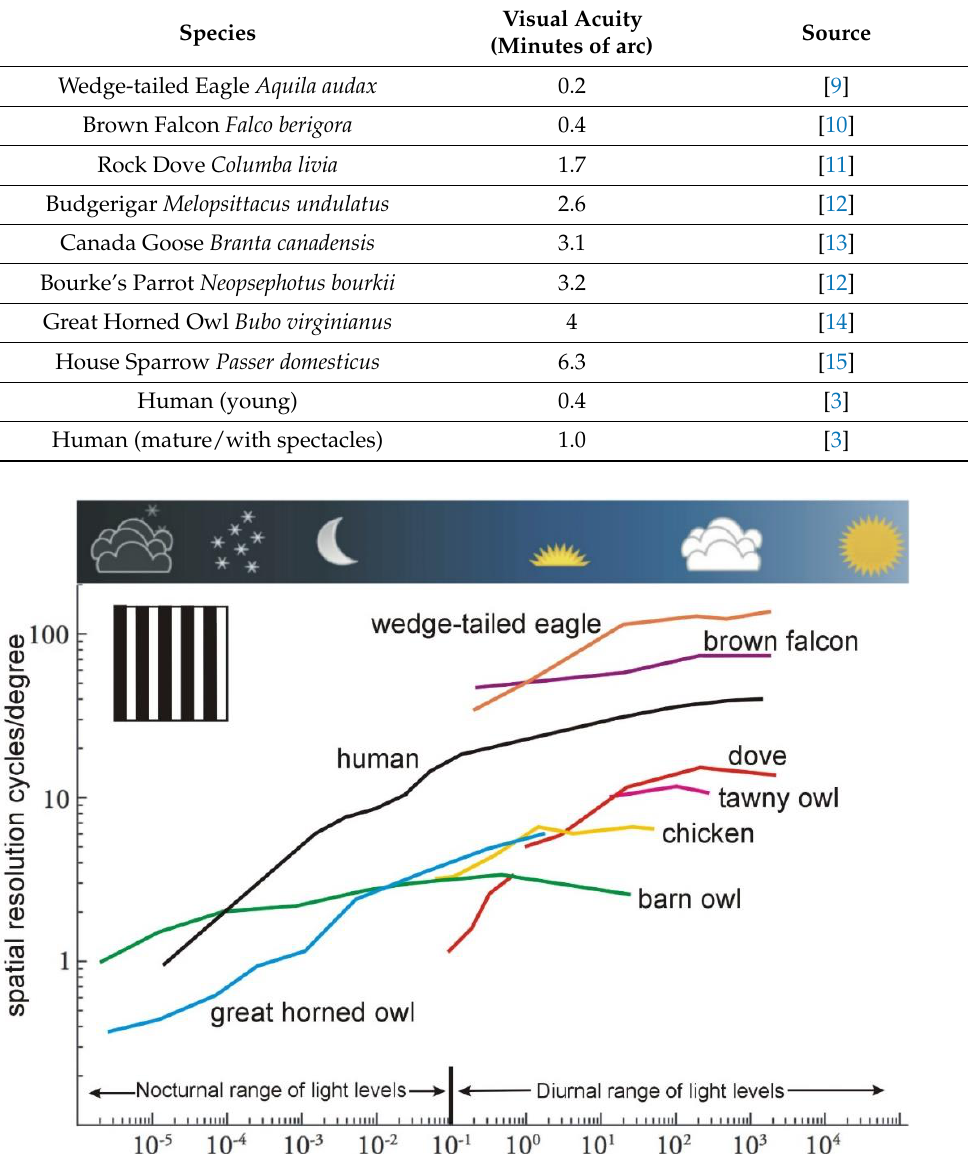
Table 1. Spatial resolution (visual acuity) in a sample of bird species and in humans. All measures refer to acuity at high daytime light levels and indicate the best performance (finest spatial detail that can be resolved using high contrast stimuli). To compare between species simply divide their acuity values. Thus, the goose’s resolution is about 7 times higher than that of a young human. Expressed another way, a young human should be able to detect a given object 7 times further away than a goose, while an older human can detect the same object 3 times further away.